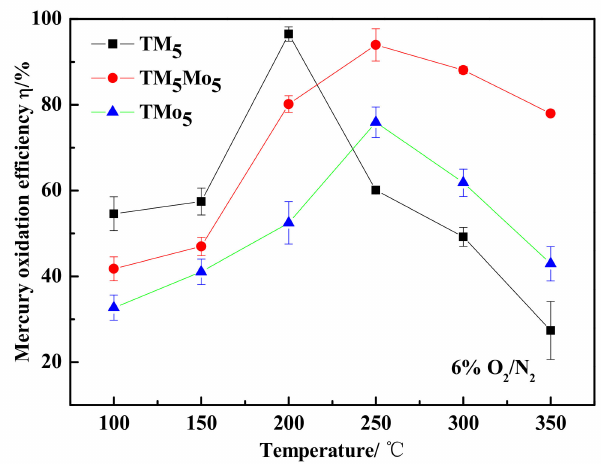
Figure 6. The e ff ect of temperature on mercury oxidation over TM 5 Mo